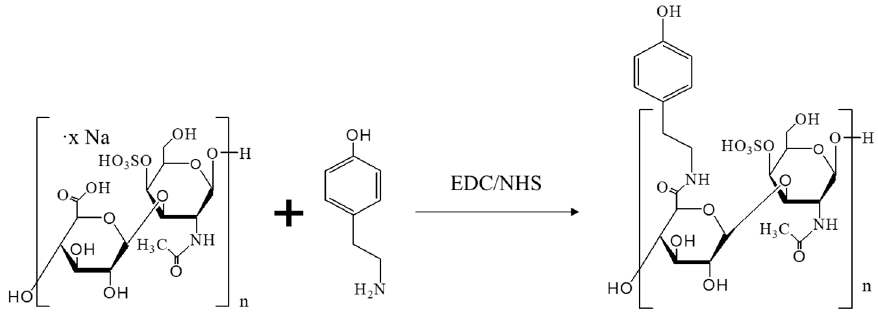
Figure 10. Chemical synthesis of CS-Tyr through EDC/NHS reaction. Briefly, 500 mg of chondroitin-4-sulfate sodium salt from bovine trachea (Sigma Al- drich, Burlington, MA, USA) was dissolved in 10 mL of MES buffer solution (19.52 g of 2- ( N -morpholino)ethanesulfonic acid hydrate (MES) (Sigma Aldrich, Burlington, MA, USA) was dissolved in 1 L of deionized water and the pH was adjusted to 4.5, 100 mM), 141.9